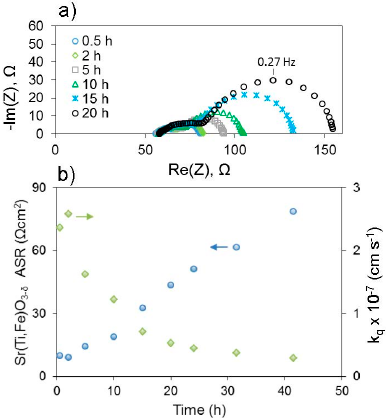
Figure 7. ( a ) Example impedance spectra changes of asymmetric cell with dense thin film (~100 nm thick) SrTi 0.65 Fe 0.35 O 3 −δ electrode over time at 873 K and 0.21 atm O 2 by Perry (unpublished; see Figure